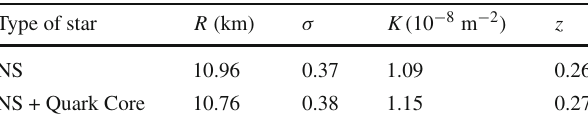
Table 3 Properties of neutron star with the gravitational mass equal to 1 . 4 M (cid:2) for NS and NS + Q Type of star